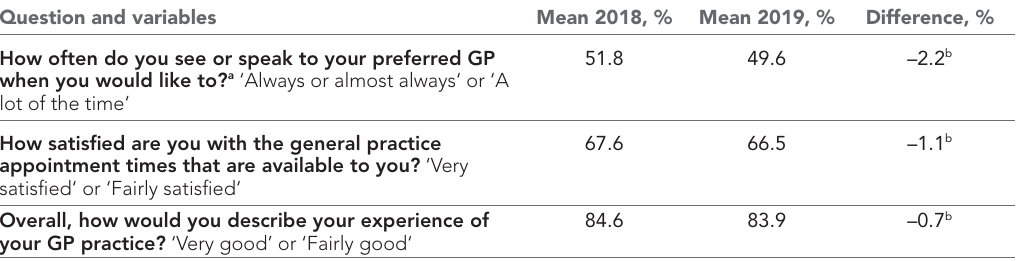
Table 1 Mean values for outcome variables for all practices included in the model ( n = 5829) Question and variables